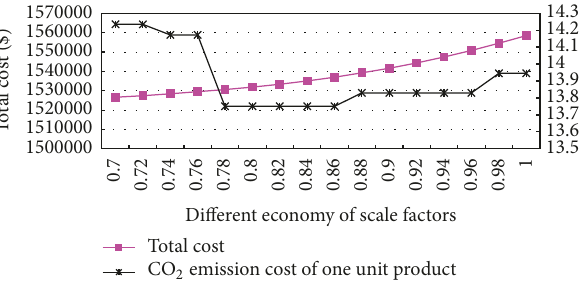
Figure 5: Total cost and CO 2 emission cost of one unit product under different economies of scale